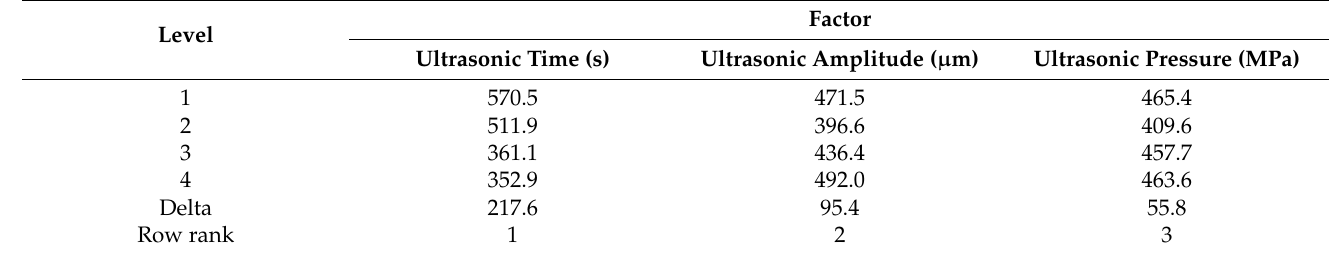
Table 3. Mean value response (unit: Ω · cm 2